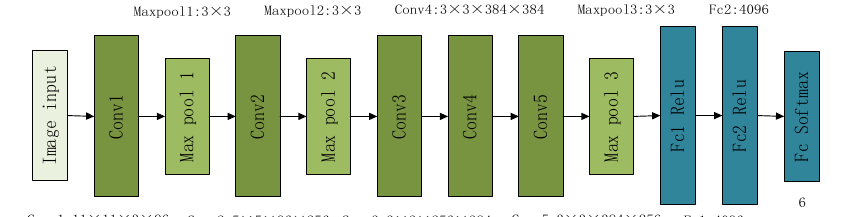
Figure 3. AlexNet basic network.